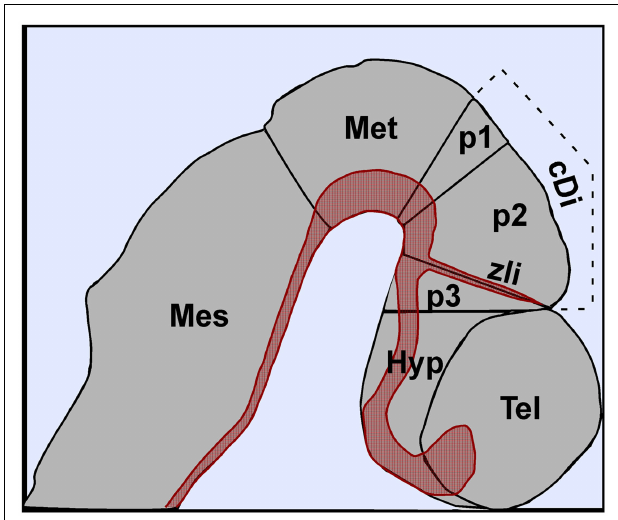
FIGURE 1 | Regionalization of the central nervous system along the anteroposterior axis of the mouse at embryonic day 10.5. The caudal diencephalon is divided into three prosomeres (p1, p2, p3) corresponding to the pretectum, thalamaus, and prethalamus, respectively.The zona limitans intrathalamica (zli) is located at the p2–p3 boundary.The expression of Shh in the ventral midline and zli is depicted in red. Abbreviations: cDi, caudal diencephalon; Hyp, hypothalamus; Mes, mesencephalon; Met, metencephalon;Tel,